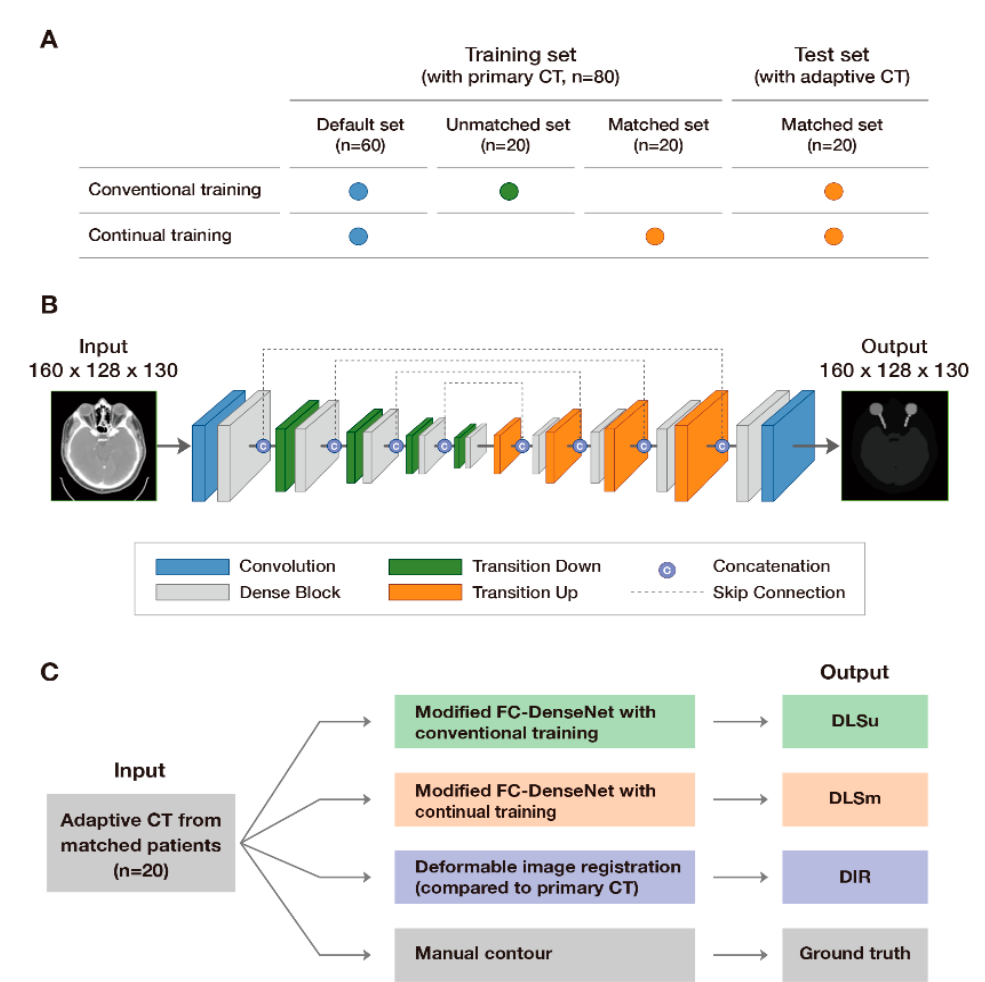
Figure 1. Study scheme: allocation of input data ( A ), architecture of modified FC-DenseNet ( B ), and model validation ( C ).